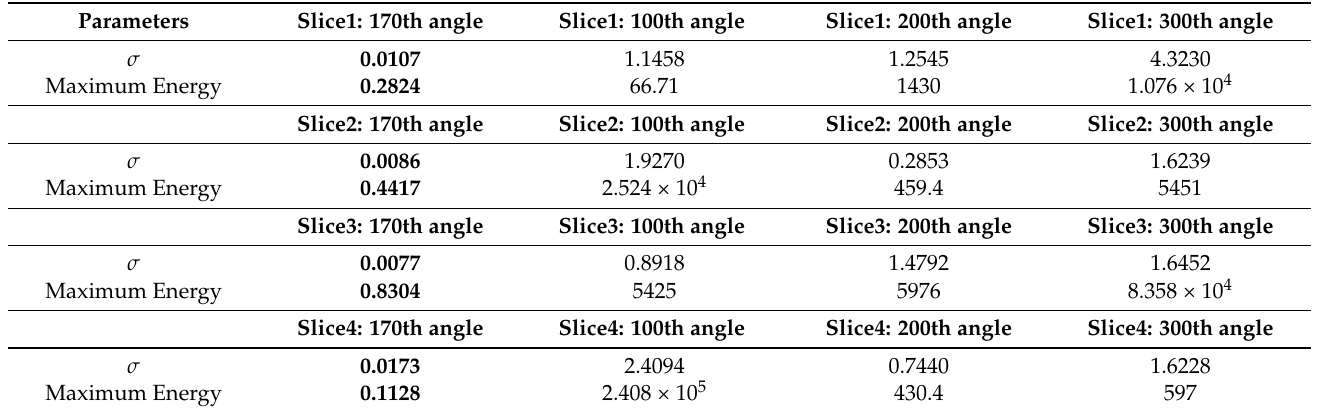
Table 5. Four slices of warehouse comparison from angle and value: minimum σ value appeared around 170th angle (100th, 200th, 300th angle as comparative analysis